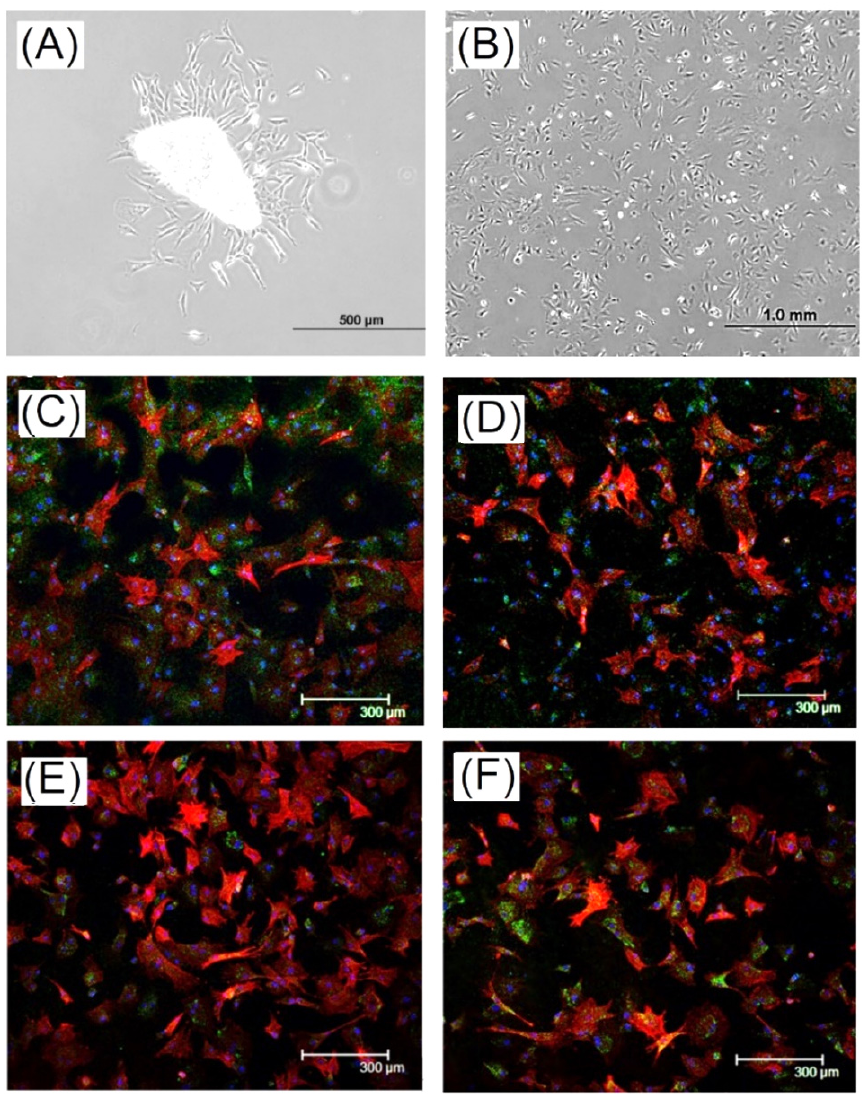
Figure 5. O.D. images of ( A ) culture of rabbit knee articular cartilage fragment (chondrocyte) and ( B ) primary chondrocytes (P0) (40 x) and immunofluorescence staining results of chondrocytes, green-specific protein, ( C ) type II collagen, ( D ) MMP13, ( E ) aggrecan, and ( F ) sox9; blue-nucleus and red-cytoskeleton.